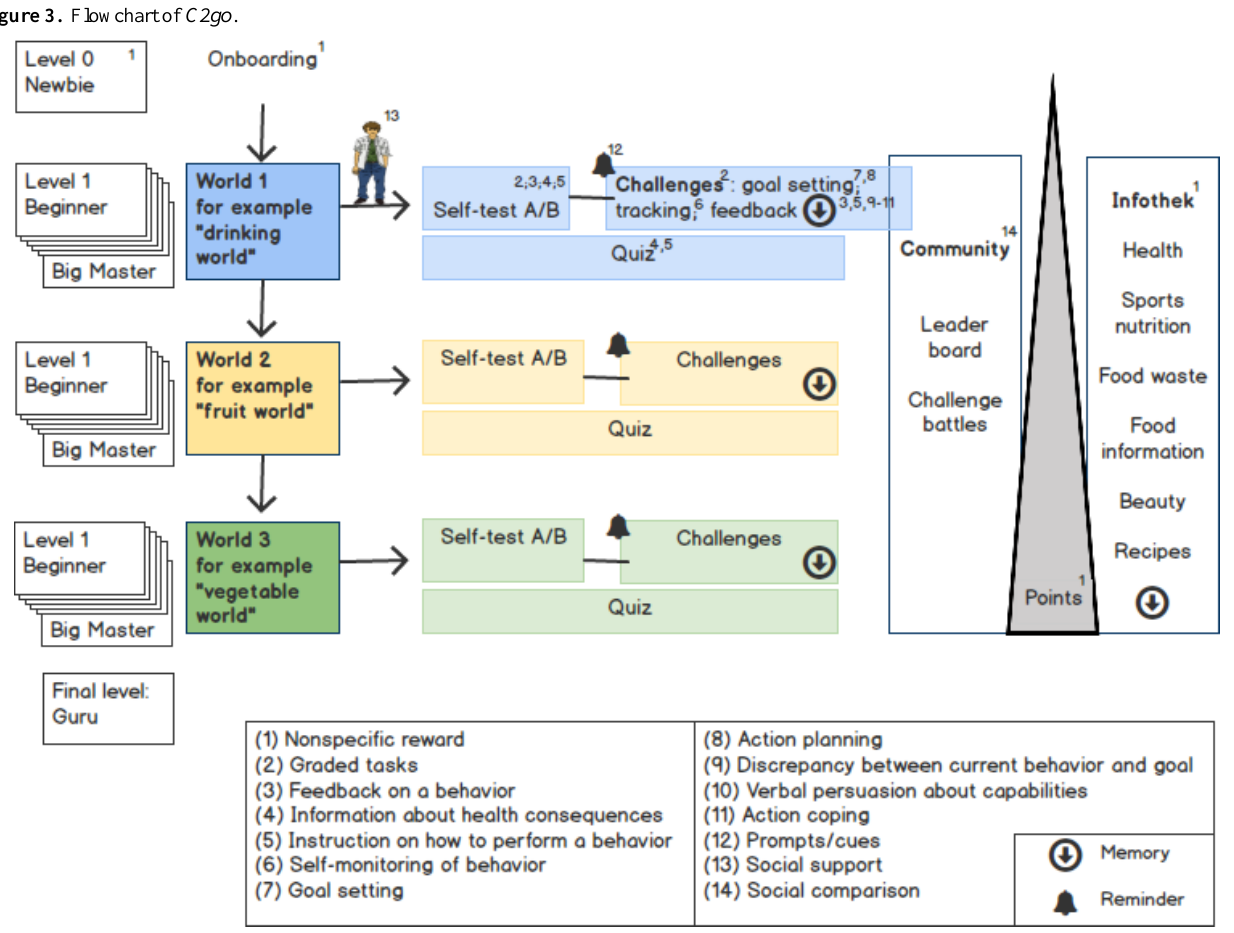
Figure 3. Flowchart of C2go